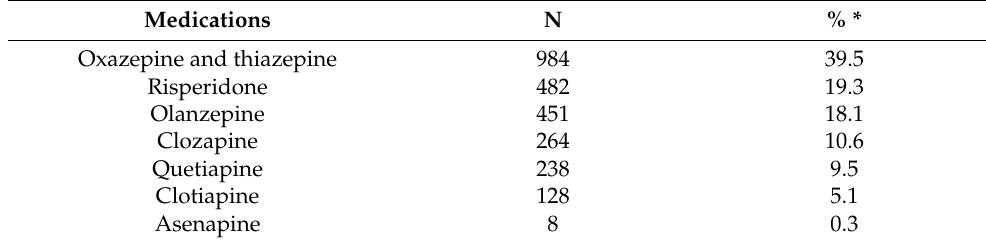
Table 2. Distribution of patient antipsychotic medication. Medications N